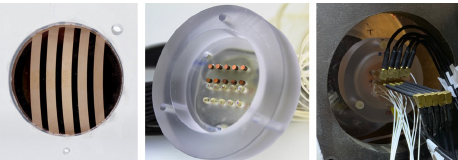
Figure 7. Images showing left —rear of the target mounted in the lexan plate, center —back of the diagnostics package showing the LN pins (top two rows) and PDV probes (bottom two rows), right —rear of the target and diagnostics assembly mounted in the gas